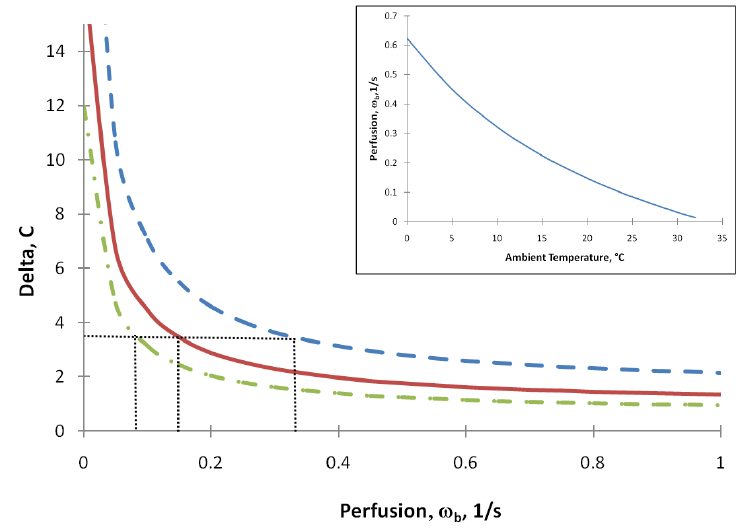
Figure 4. The dependence of the temperature drop across the skin ( Delta ) on the perfusion rate for several ambient temperatures: 25 °C (green dot-dash line), 20 °C (solid red line), and 10 °C (blue dashed line). The black dotted line outlines the broadly reported value for Delta (3.5 °C). Insert : calculated perfusion rate (solid blue line) to keep Delta at 3.5 °C as a function of the ambient temperature, T ∞